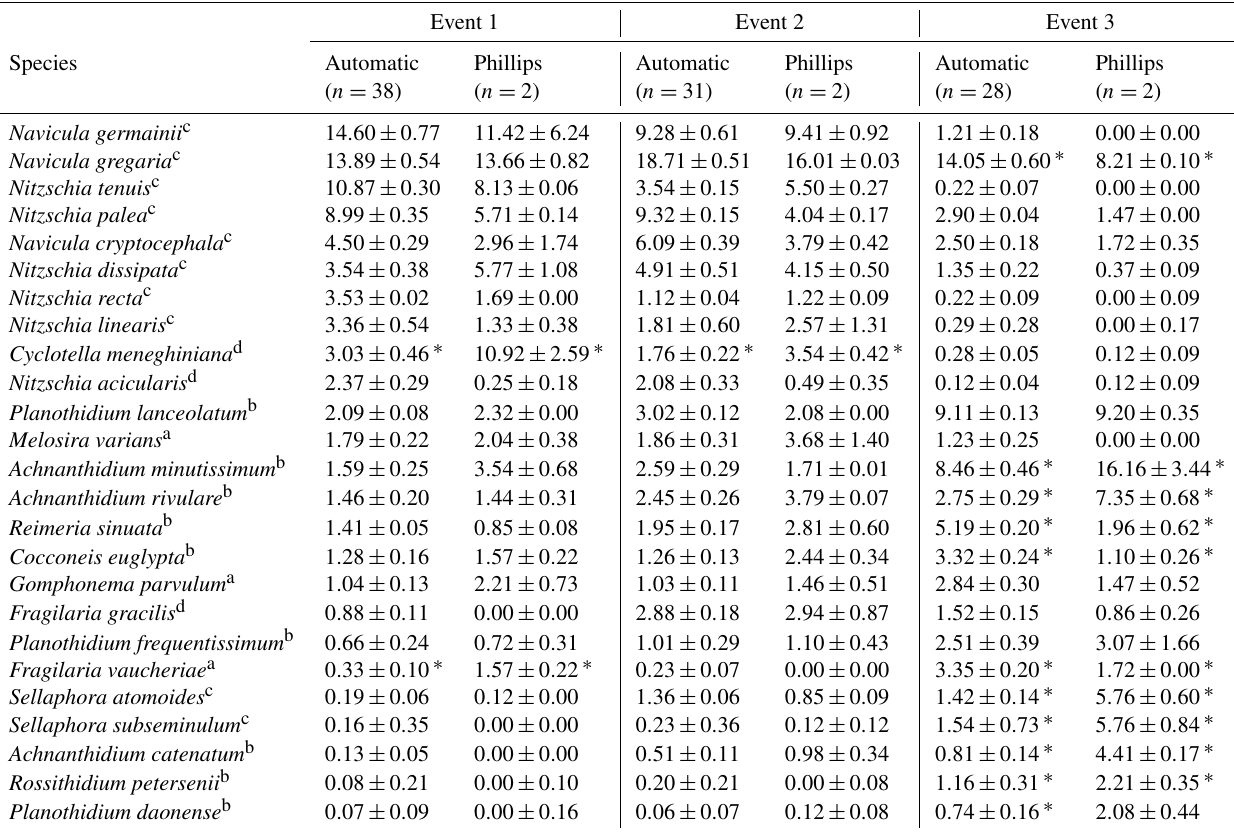
Table 2. Most abundant diatom species for the whole study campaign. The weighted averages (in percent) and standard error of the relative abundances are given. An ”*” indicates that the species relative abundance is significantly different between the two sampling methods for that